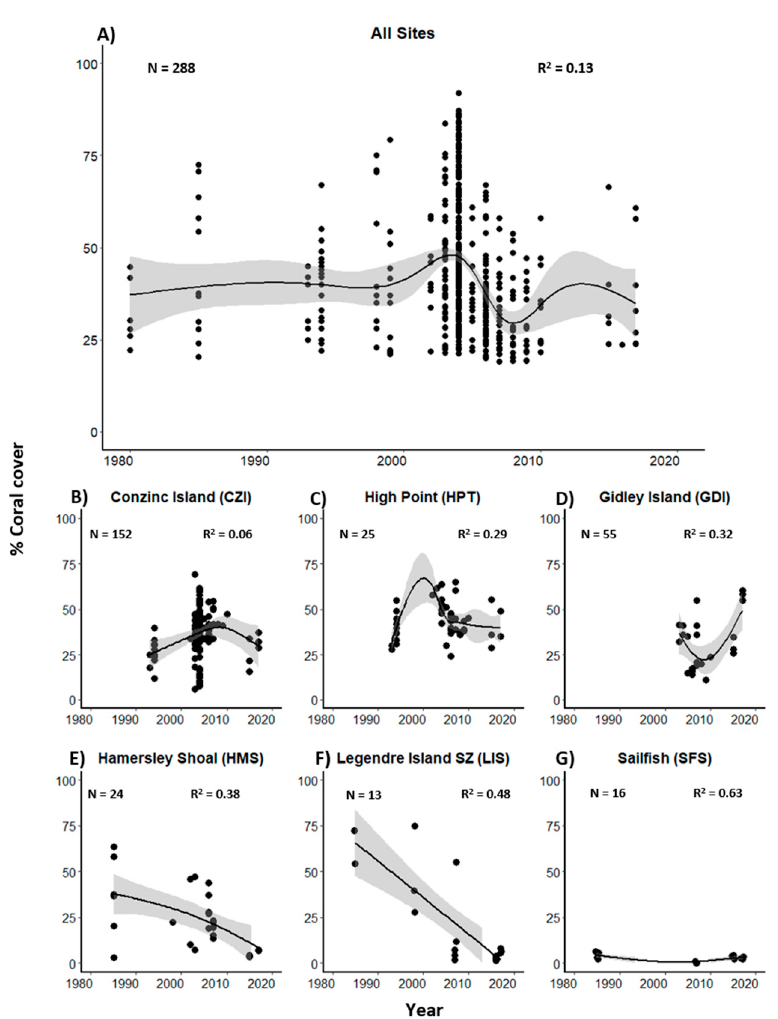
Figure 2. Percent live coral cover over time throughout the entire Dampier Archipelago, Western Australia, and at six study sites. The black line is the best generalised additive model (GAM) ± standard error (grey shading).